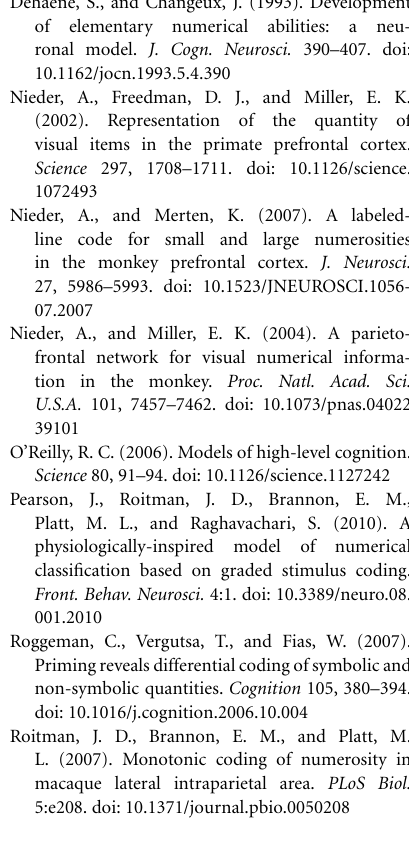
plotted against the numerical distance from the preferred numerosity. (C,F) simulated frequency distributions of the preferred numerosities for VIP (C) and PFC (F) ,